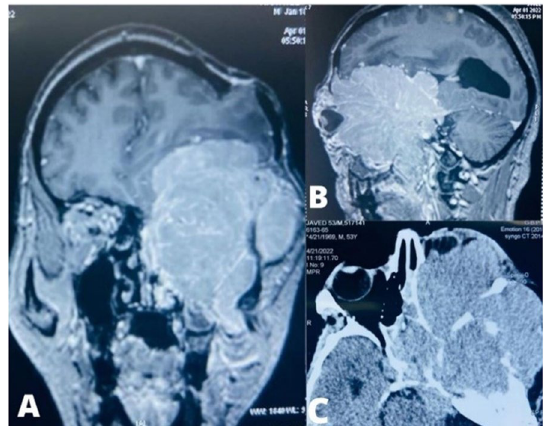
Fig. 2 Contrast-enhanced MRI of the brain with brain and paranasal sinus. A , B Coronal and sagittal post-contrast T1W images of the head reveal a large lobulated solid heterogeneously enhancing mass centred in the region of the left sphenoid wing extending into the sphenoid sinus, sella turcica, left ethmoid and maxillary sinuses, left nasal cavity and left orbit with involvement of extraocular muscles and optic nerve, resulting in proptosis and deformation of the left globe. Intracranial extension into the frontal and temporal regions is also seen. C Axial non-contrast CT of the head reveals the mass to be homogeneously hyperdense to grey matter and shows bone destruction in the region of the body and left greater and lesser wings of the